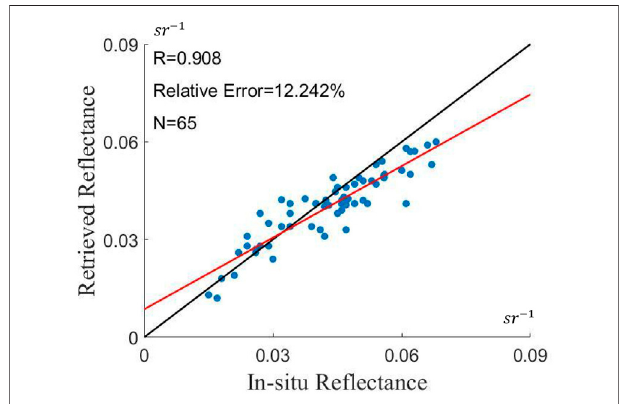
FIGURE 3 | Comparison of in situ measurements and the retrieved re fl ectance at nadir view of MISR with the ASRVN method.